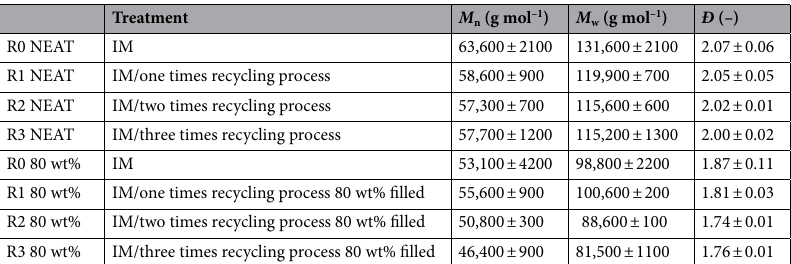
Table 1. Molecular weights and polydispersity index obtained from GPC